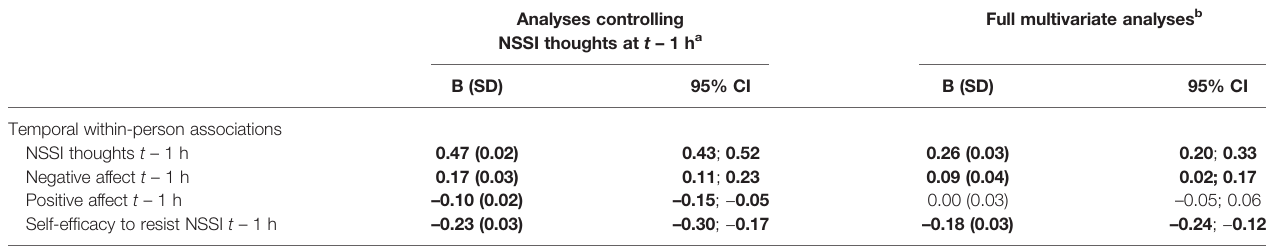
TABLE 4 | Temporal within-person associations between affective states, self-ef fi cacy to resist NSSI, and non-suicidal self-injurious thoughts.